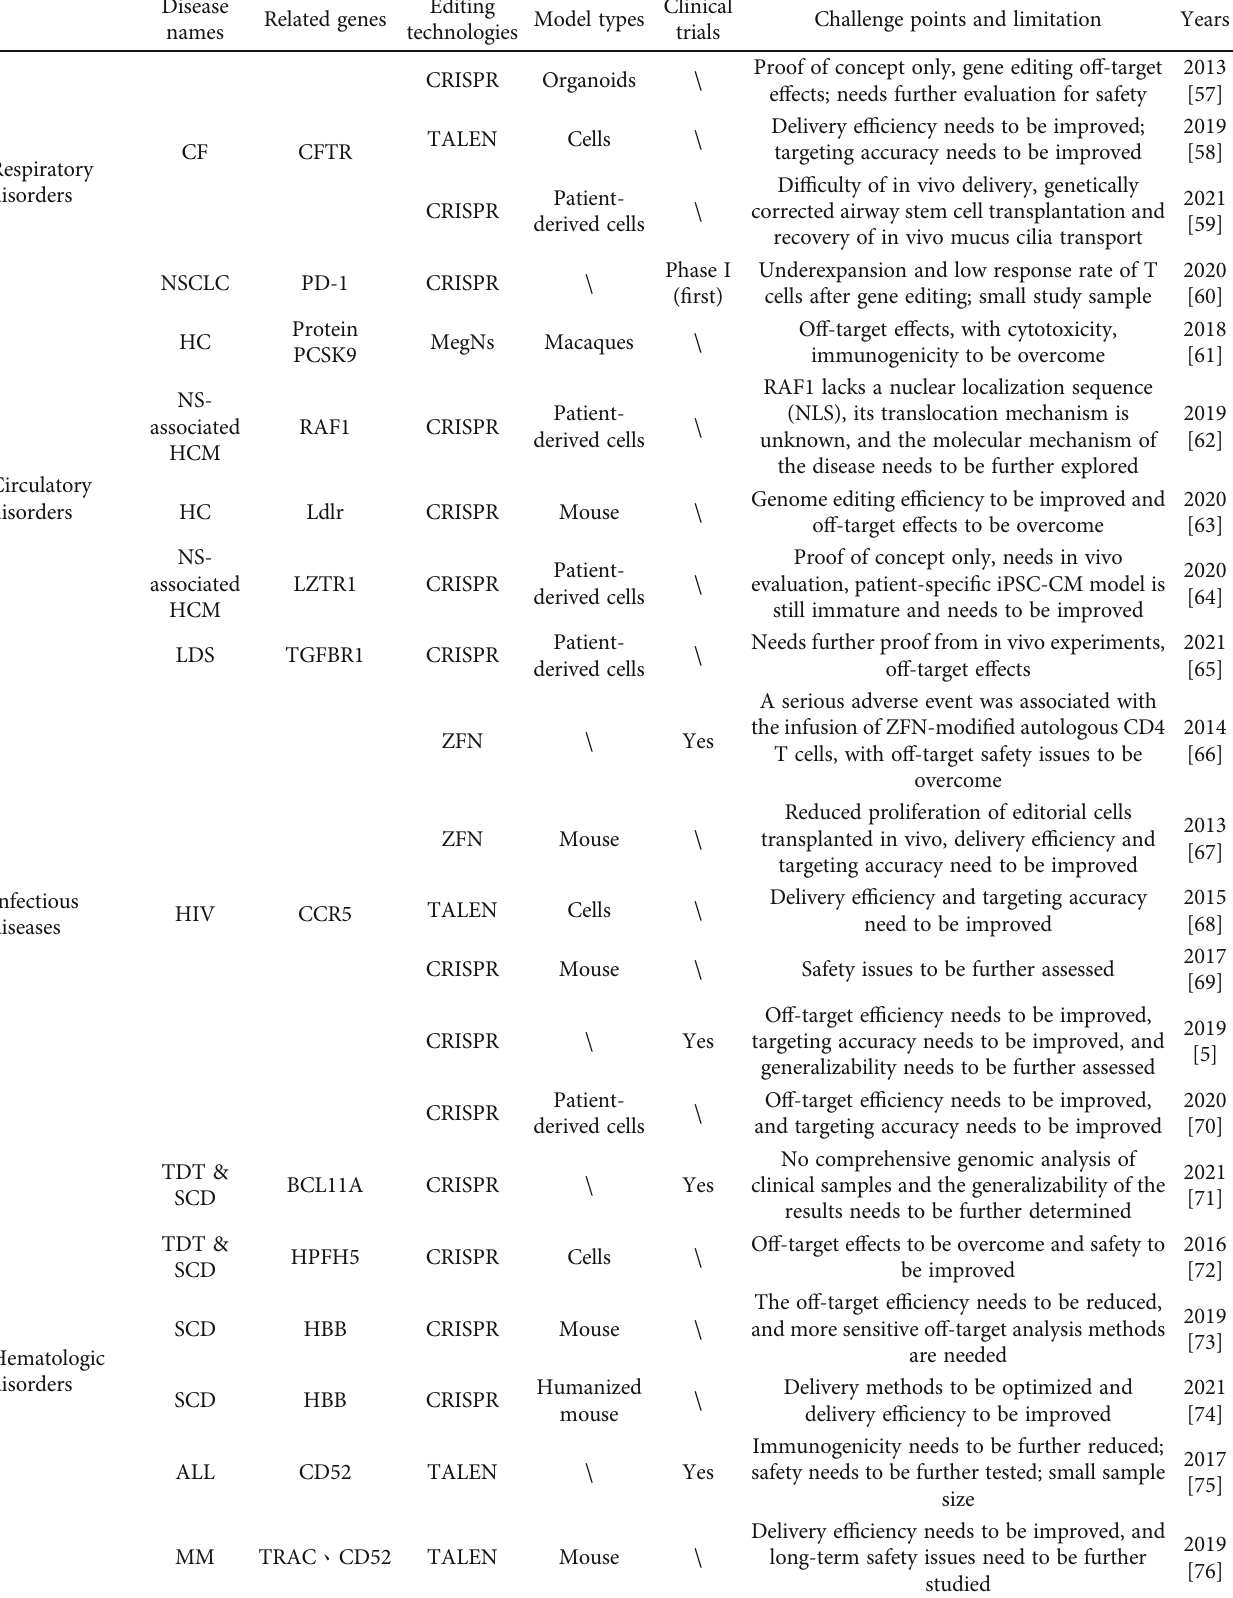
Table 3: Current challenges of gene editing in di ff erent